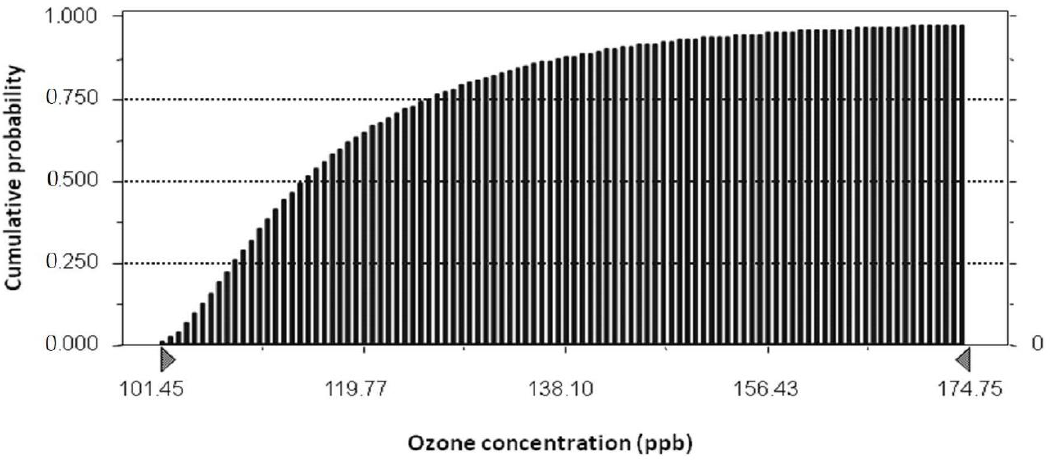
Figure 4. Monte Carlo analysis results reached after 20,000 simulation trials, showing the cumulative probability plot for ozone concentrations in front of the dryer for a very short period after accidentally opening the machine while it was working empty, with an ozone source of 5 mg/h.